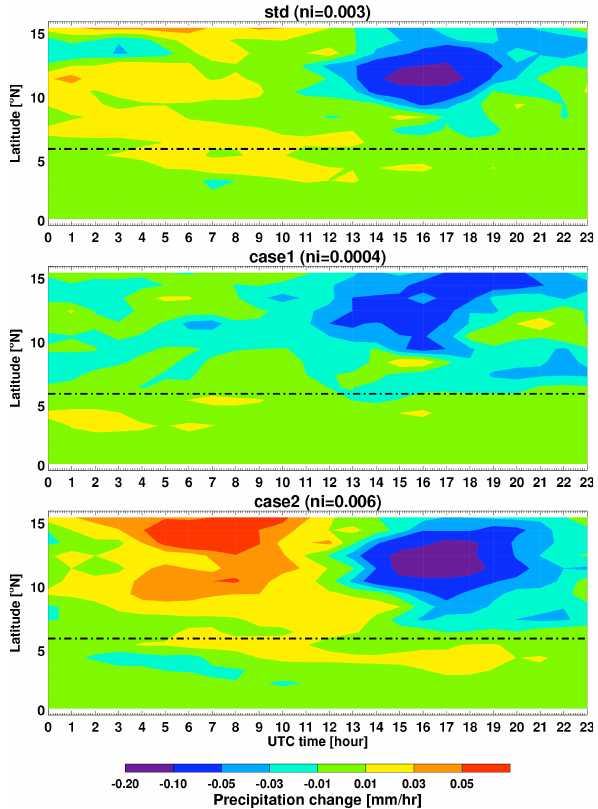
Fig. 7. Dust impact on the diurnal cycle of zonal averaged pre- cipitation between 15 ◦ W–10 ◦ E from WRF-Chem in three cases with different dust absorption properties. The dashed line shows the Guinean coast. The dust impact is calculated by subtracting the precipitation from the simulation without dust from that with dust. “ n i ” represents the imaginary part of the refractive index of dust.